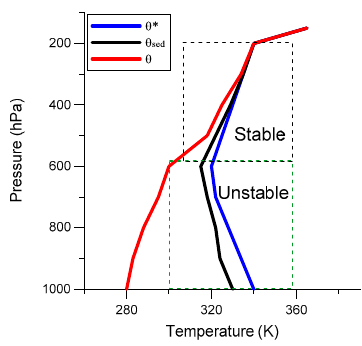
Figure 1. Schematic of the “3 θ ” energy analysis method.